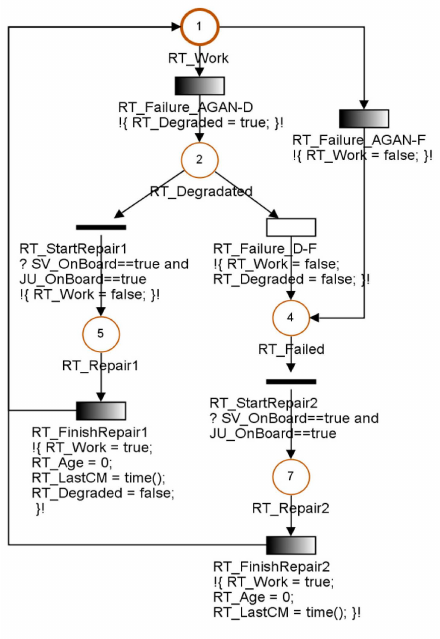
Figure 2. PN model of equipment